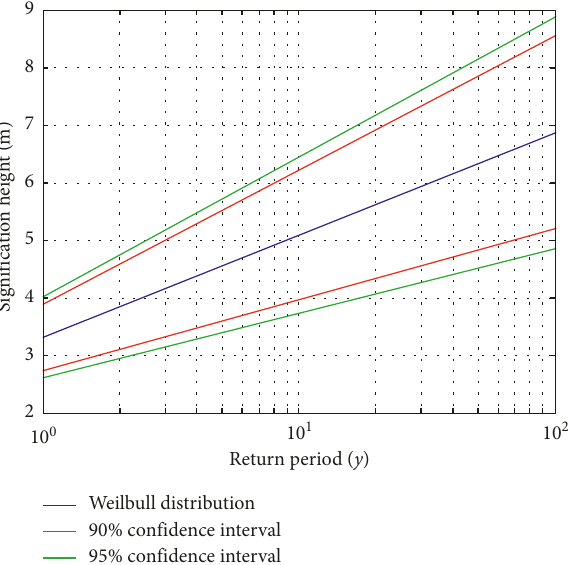
Figure 5: Wave dataset composed of 53 peak wave heights (in terms of significant height H the RON buoy.